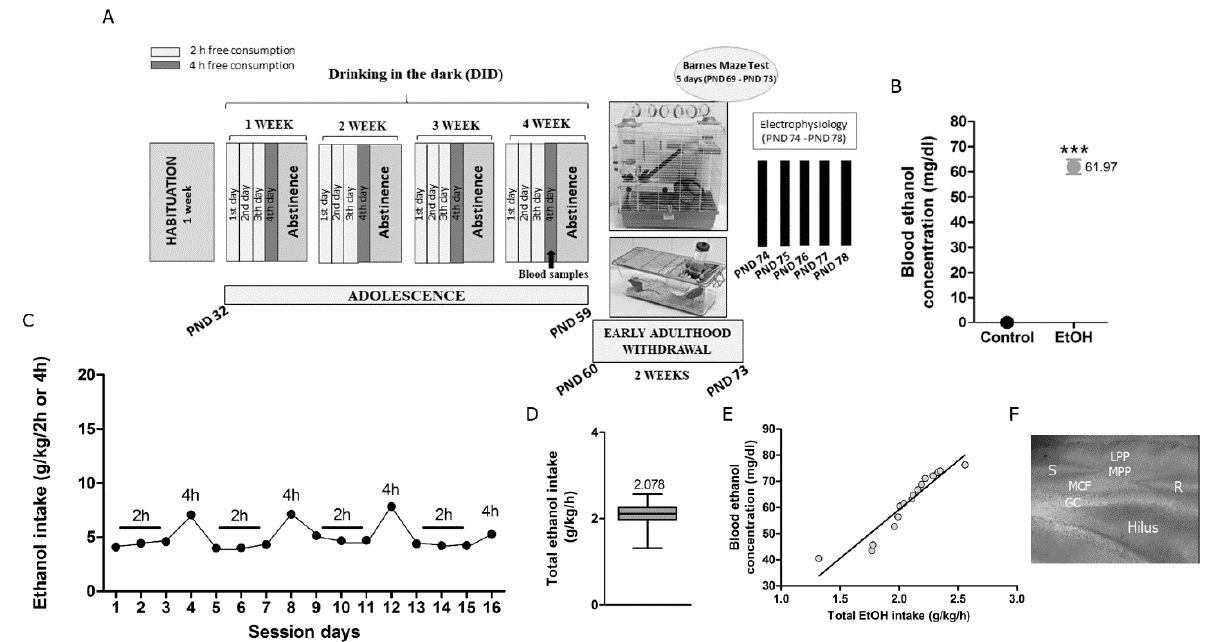
Figure 1. Schematic representation of experimental timeline, BEC, daily voluntary oral EtOH intake, total EtOH intake, and correlation between total EtOH intake and BEC. ( A ) Male C57BL/6J mice were exposed to 4 weeks DID during adolescence (PND 32–56). Each week, mice were exposed to 2 and 4 h of free EtOH access (20% ( v / v )). Several mice were under environmental enrichment over the 2 weeks of withdrawal (PND 60–73) and were subjected to the Barnes maze test in the last 5 days (PND 69–73). Then, they were sacrificed to perform physiological recordings at early adulthood (PND 74–78). ( B ) BEC obtained on the last day of EtOH exposure averaged 61.97 ± 2.84 mg/dL (( n = 16) Student’s t-test; *** p = 0.0001 vs. control). ( C ) EtOH intake during each day (g EtOH/kg/2 or 4 h) was measured and ( D ) total EtOH intake averaged 2.078 ± 0.07 g/kg/h ( n = 16), similar to previous studies [5,17,32]. ( E ) A direct correlation between total EtOH intake and BEC was detected. ( F ) Stimulating electrode (S) was placed in the middle one-third of the DGML to stimulate MPP. R recording electrode, GC granule cells, MCF mossy cell fibers, MPP medial perforant path, LPP lateral perforant path.